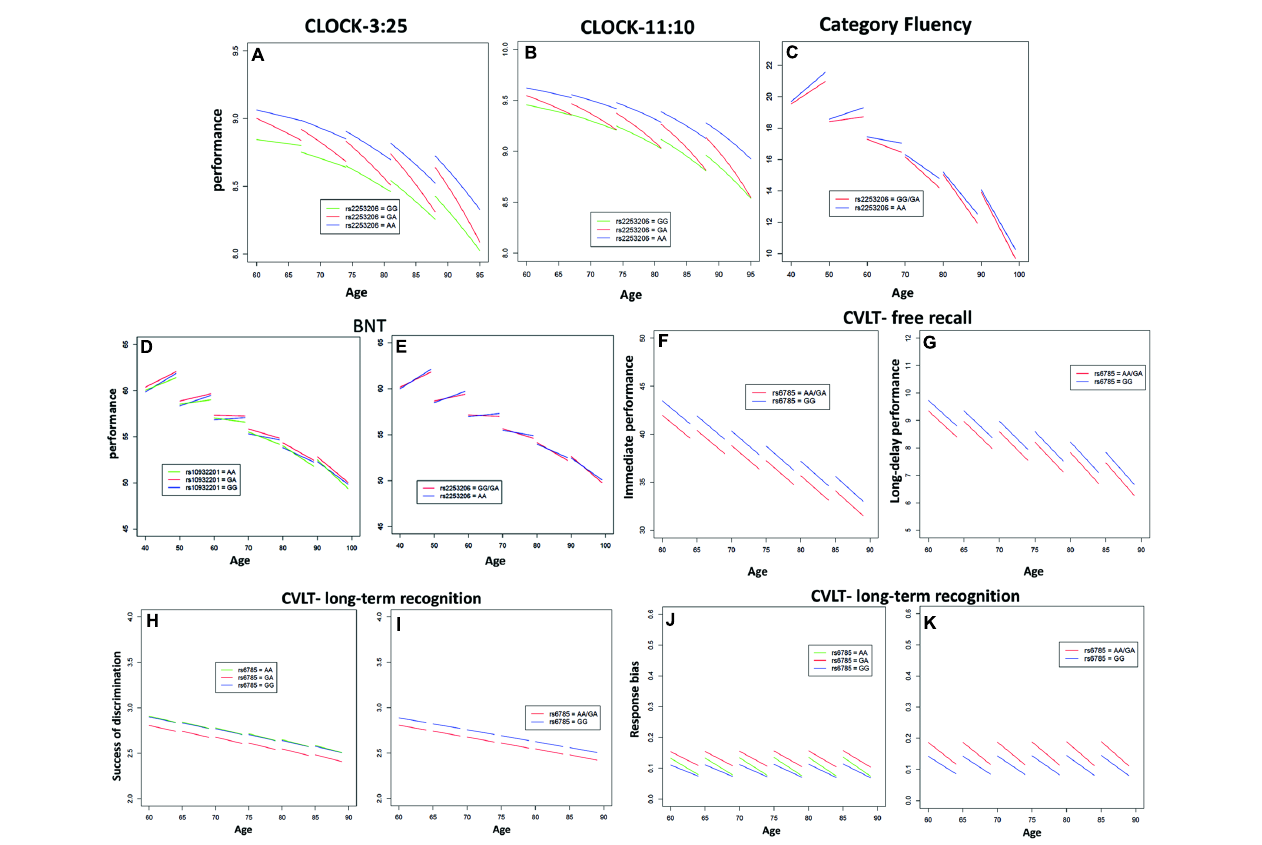
FIGURE 1 | Significant effects of CREB1 genotypes on the longitudinal population-average trajectories for performance measures of executive function and/or memory (A) CLOCK-3:25, (B) CLOCK-11:10, (C) Category Fluency, (D,E) BNT, (F) California Verbal Learning Test (CVLT)-immediate free recall, (G) CVLT-long-delay free recall, (H,I) CVLT-recognition discriminability, and (J,K) CVLT-recognition response bias based on the predicted values after adjusting for baseline age, sex, education, and APOE ε 4 status. All the effects were estimated using linear mixed effects (LME) models except for CLOCK measures where generalized estimating equations (GEE) models were used.